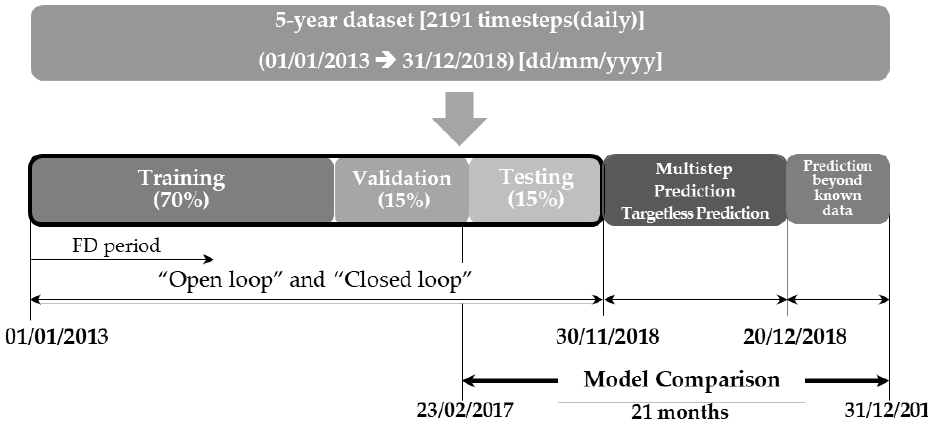
Figure 5. Experimental design of neural network modelling for power demand prediction.